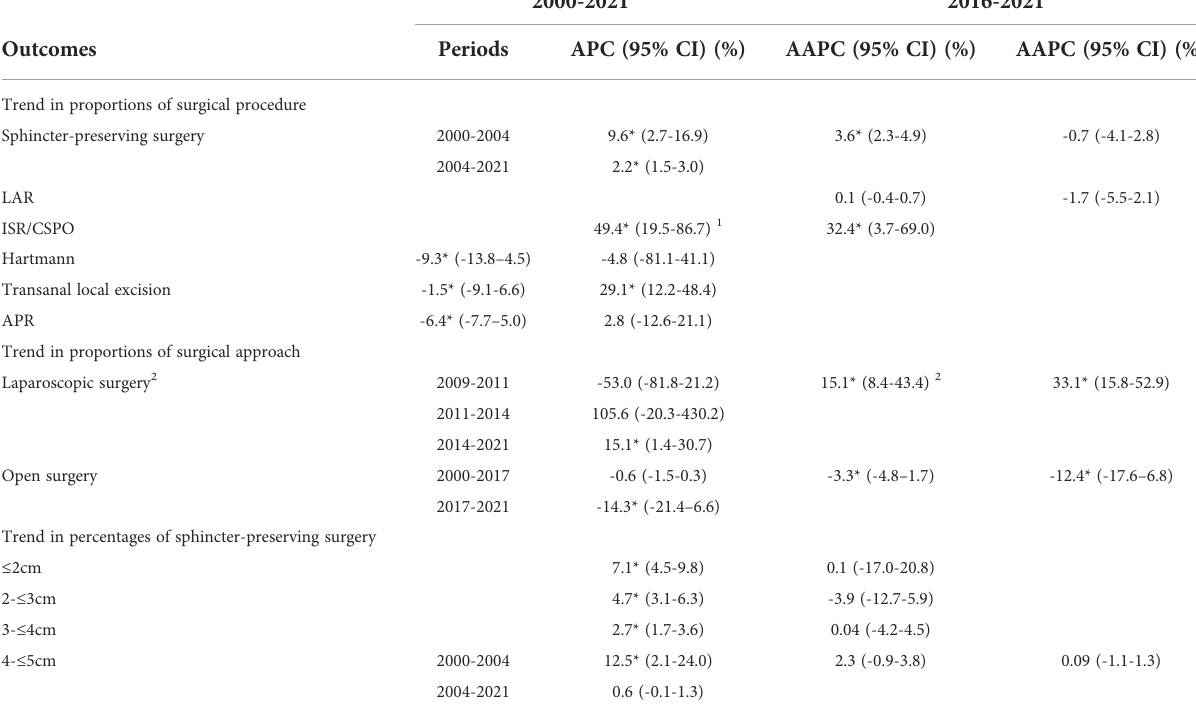
TABLE 2 Trends in surgical techniques for low rectal cancer between 2000-2021 and